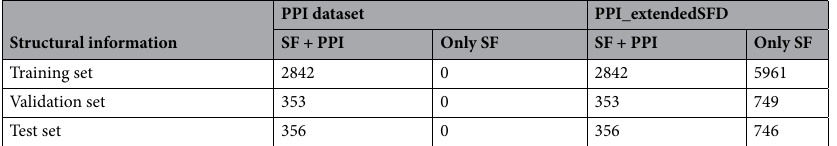
Table 1. The number of proteins in the training, validation and test sets for the PPI and PPI_extendedSFD datasets. The PPI dataset only contains proteins for which both structural features and PPI interface annotations are available. The PPI_extendedSFD dataset contains additional proteins for which only structural features are